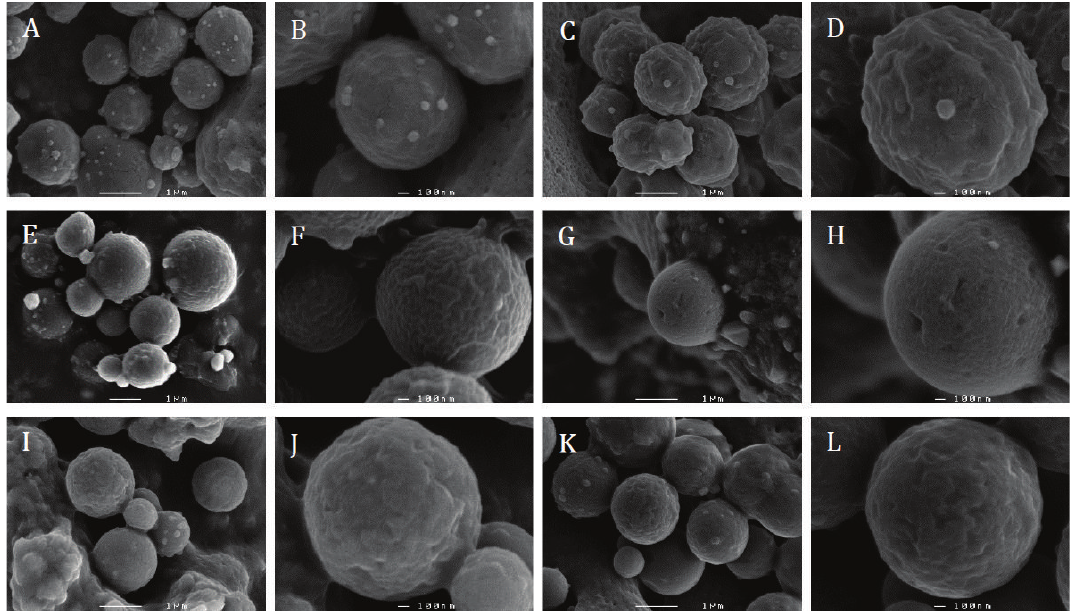
Figure 1: Scanning electron micrograph of empty and prednisolone-loaded microparticles made using kafirin extracted from raw white grain, raw red grain, and cooked red grain. (A, B) empty and (C, D) prednisolone-loaded microparticles of kafirin from raw white grain; (E, F) empty and (G, H) prednisolone-loaded microparticles of kafirin from raw red grain; and (I, J) empty and (K, L) prednisolone-loaded microparticles of kafirin from cooked red grain. Scanning electron micrographs (A), (C), (E), (G), (I), and (K) were captured at 20,000x while (B), (D), (F), (H), (J), and (L) were captured at 50,000x